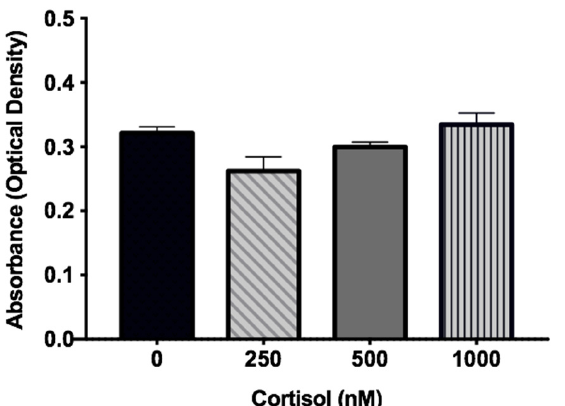
Figure 5. Chemokine gene expression. RT-qPCR of CXCL12 ( A ) and CXCR4 ( B ) in SGHPL-4 cells treated with continuous or intermittent exposure to cortisol (100, 250, 500, 1000 nM) and vehicle (0 nM) in the medium. Data were compared by two-way ANOVA with Tukey multiple comparisons test. Interaction between (continuous or intermittent) exposure to cortisol and cortisol dose was found for CXCL12 ( p = 0.0027). Data are presented as mean ± SEM. * p < 0.05; ** p < 0.01; *** p < 0.001; **** p < 0.0001; for continuous exposure: a, p < 0.0001 vs. control. CXCL12 (SDF-1), C-X-C motif chemokine ligand 12 (Stromal cell-derived factor 1); CXCR4 , C-X-C chemokine receptor type 4. Cell treatment was repeated at least three times.